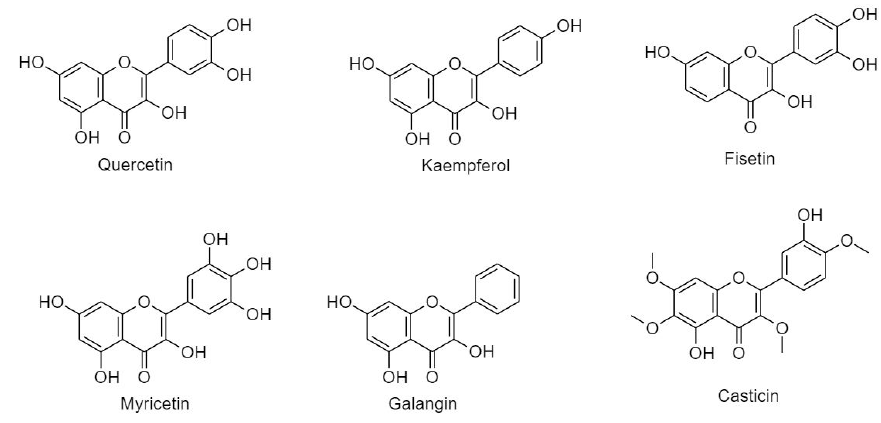
Figure 8. Classification and structure of flavonols.